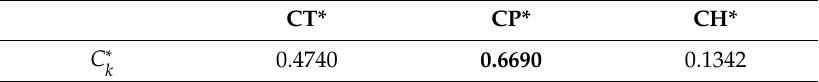
Table 6. The close indices of each case company and distances to the ideal